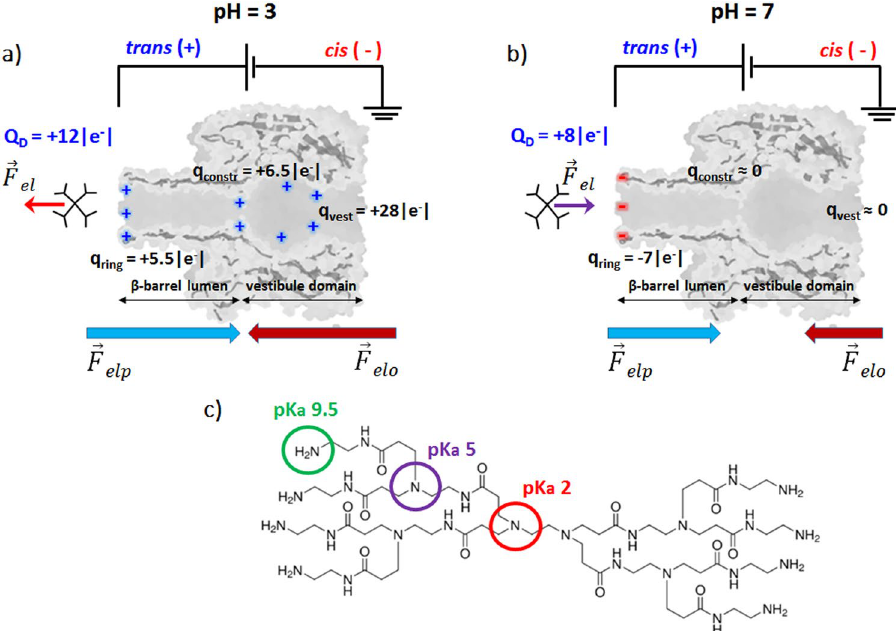
Figure 1. Principle of dendrimer detection using an α -HL nanopore inserted into a lipid membrane. A transmembrane potential difference was applied as shown, with dendrimer on the trans side of the membrane, → to generate the electrophoretic driving force ( F elp ) for dendrimer capture and transport across the nanopore. → → The sketched interplay of electrophoretic ( F elo ) acting on the PAMAM-G1 F elp ) and electro-osmotic forces ( dendrimer in acidic (pH = 3; panel a) and neutral pH (pH = 7; panel b) electrolytic solutions are represented. In panel (c) we represented the PAMAM-G1 chemical structure, displaying the eight surface primary amino groups (in green) and six tertiary amino groups (in purple and red), as well as their corresponding pK a values 47